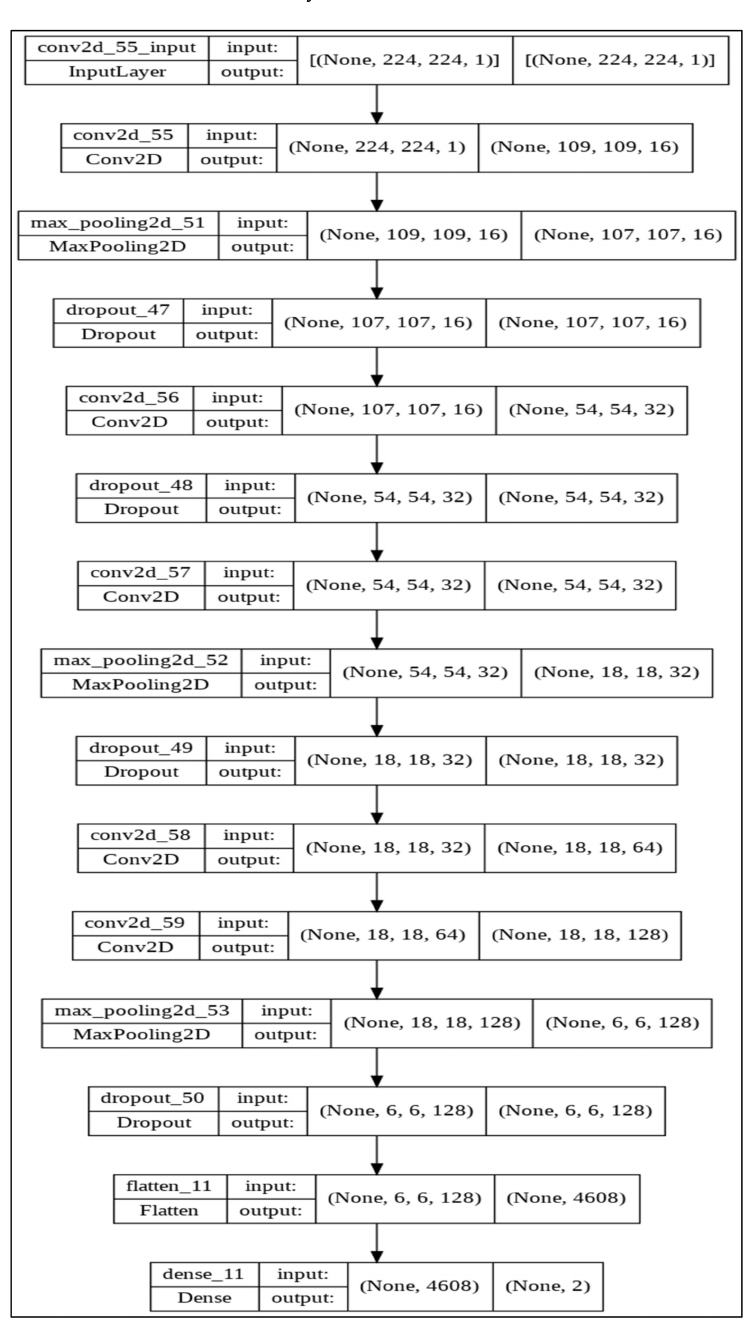
Figure 8. Block model of the proposed 5-layered CNN classifier to predict traffic